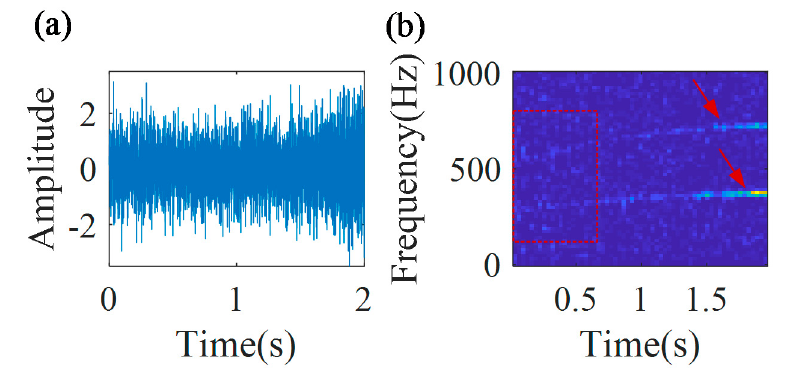
Figure 12. ( a ) Multi-component signal; and ( b ) its TFR.